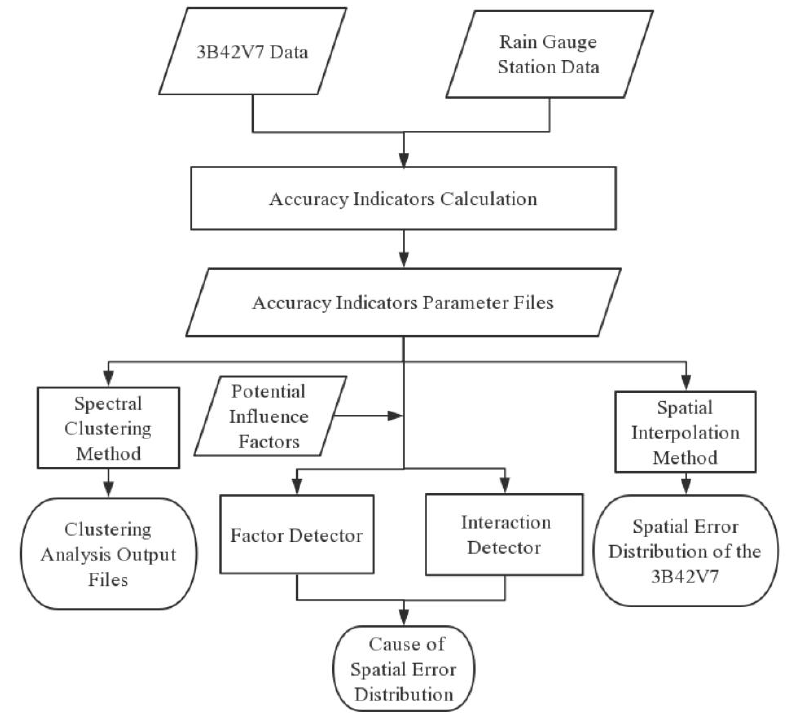
Figure 3. Flow chart of the research process.